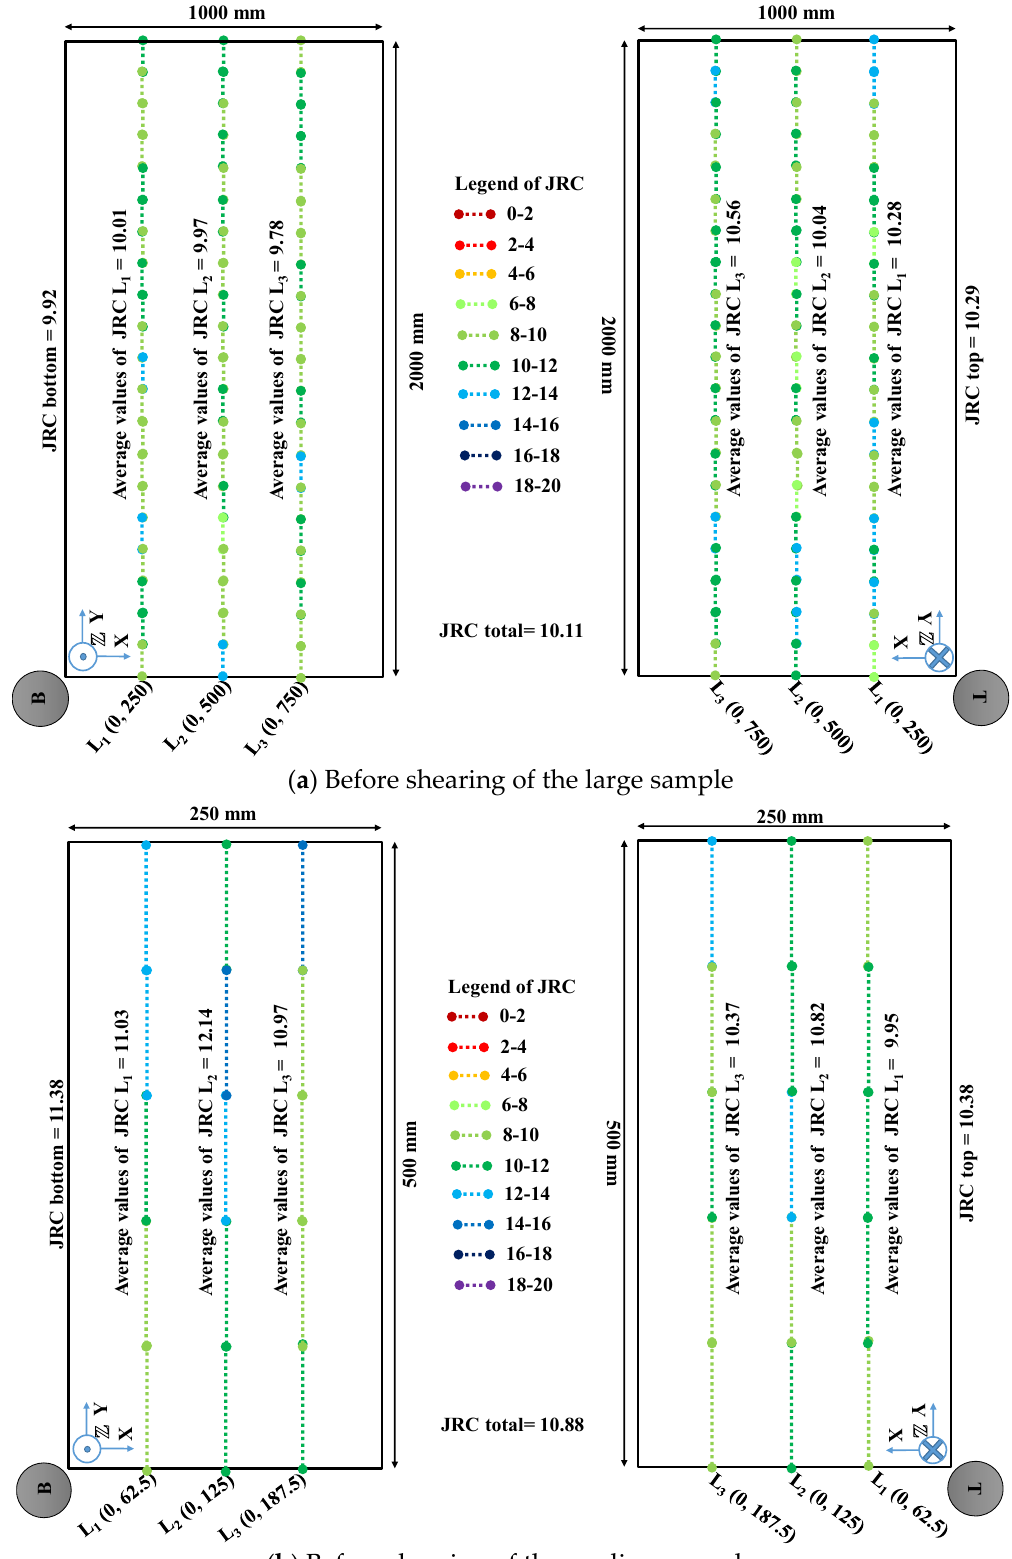
Figure 10. The photogrammetry method and Z 2 to define the JRC roughness profiles of the slabs before shearing of the large sample ( a ), before shearing of the medium sample ( b